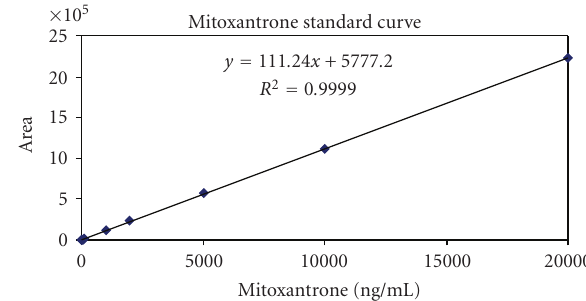
Figure 5: Mitoxantrone standard